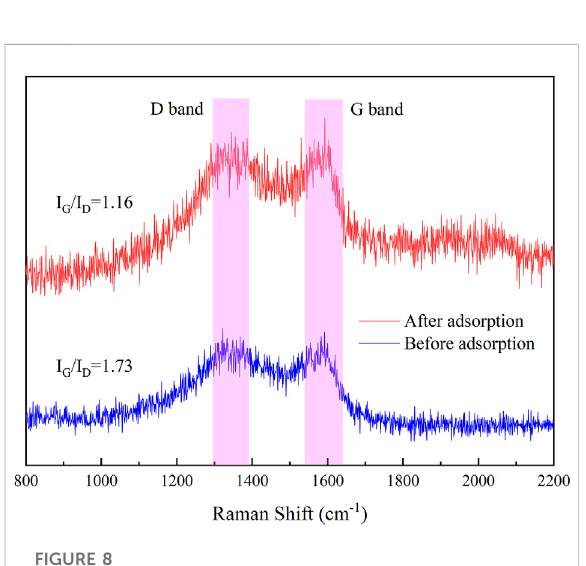
FIGURE 8 Raman spectra of IKBCH before and after TC adsorption.